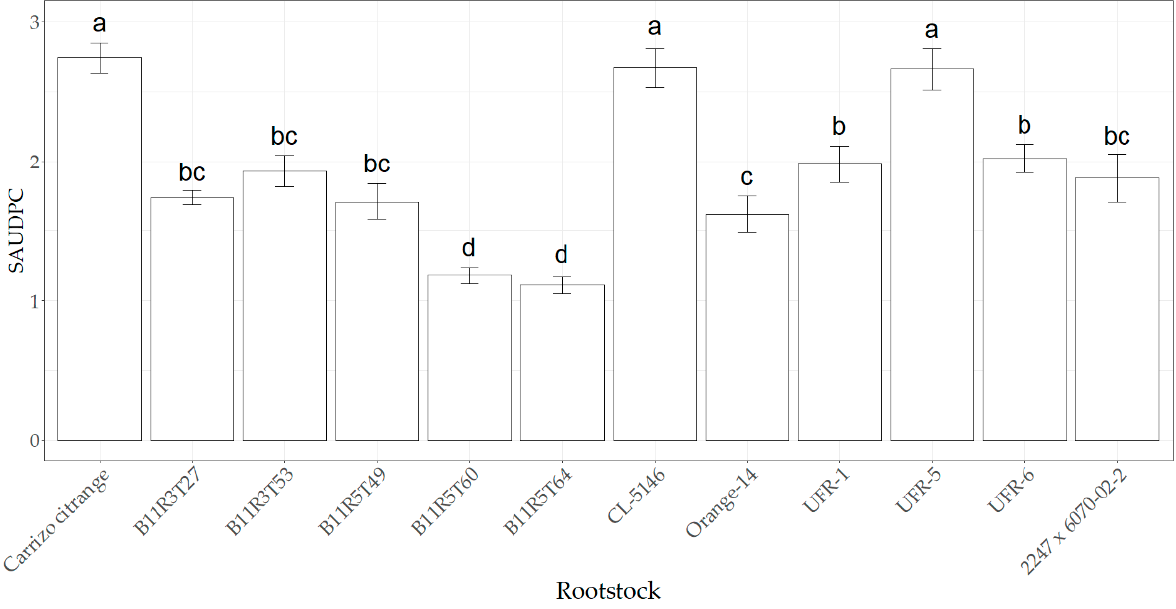
Figure 1. Mean standardized area under the disease progress curve (SAUDPC) ± standard error (SE) due to the effect of R. necatrix inoculation on aerial symptoms in 12 citrus rootstocks (Carrizo citrange, B11R3T27, B11R3T53, B11R5T49, B11R5T60, B11R5T64, CL-5146, Orange-14, UFR-1, UFR- 5, UFR-6 and 2247 x 6070-02-2). Values in columns with different letters denote statistical differences